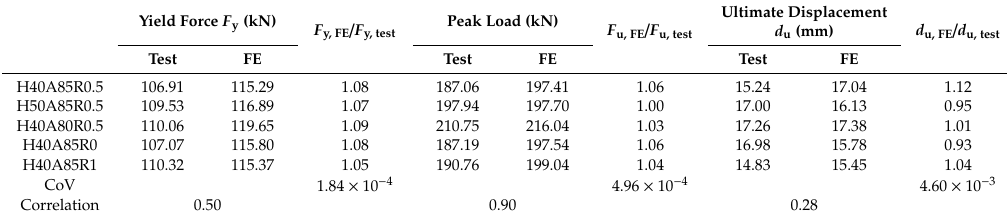
Table 2. Experimental and numerical results of specimens.